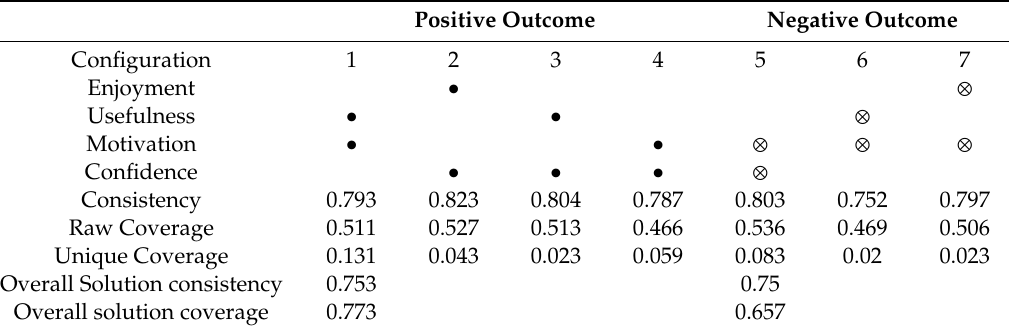
Table 3. FsQCA results. Low levels of Anxiety towards statistics as